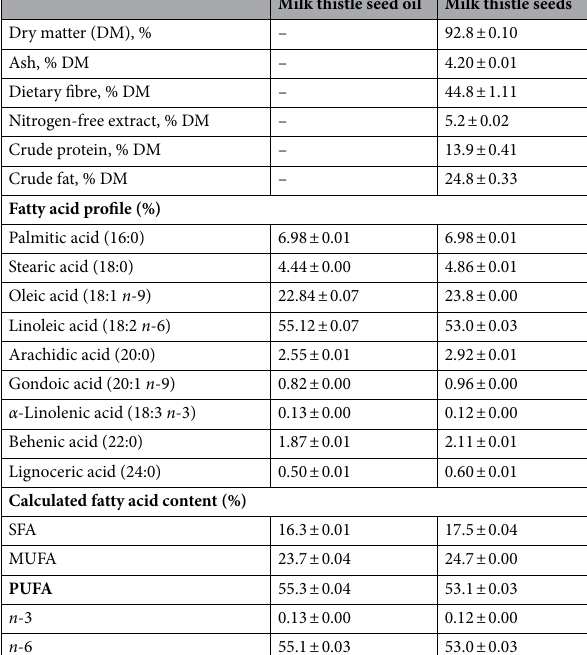
Table 1. Chemical composition of milk thistle seeds and seed oil. DM dry matter, MUFA monounsaturated fatty acid, PUFA polyunsaturated fatty acid, SFA saturated fatty acid. Values are means ± SD (n =